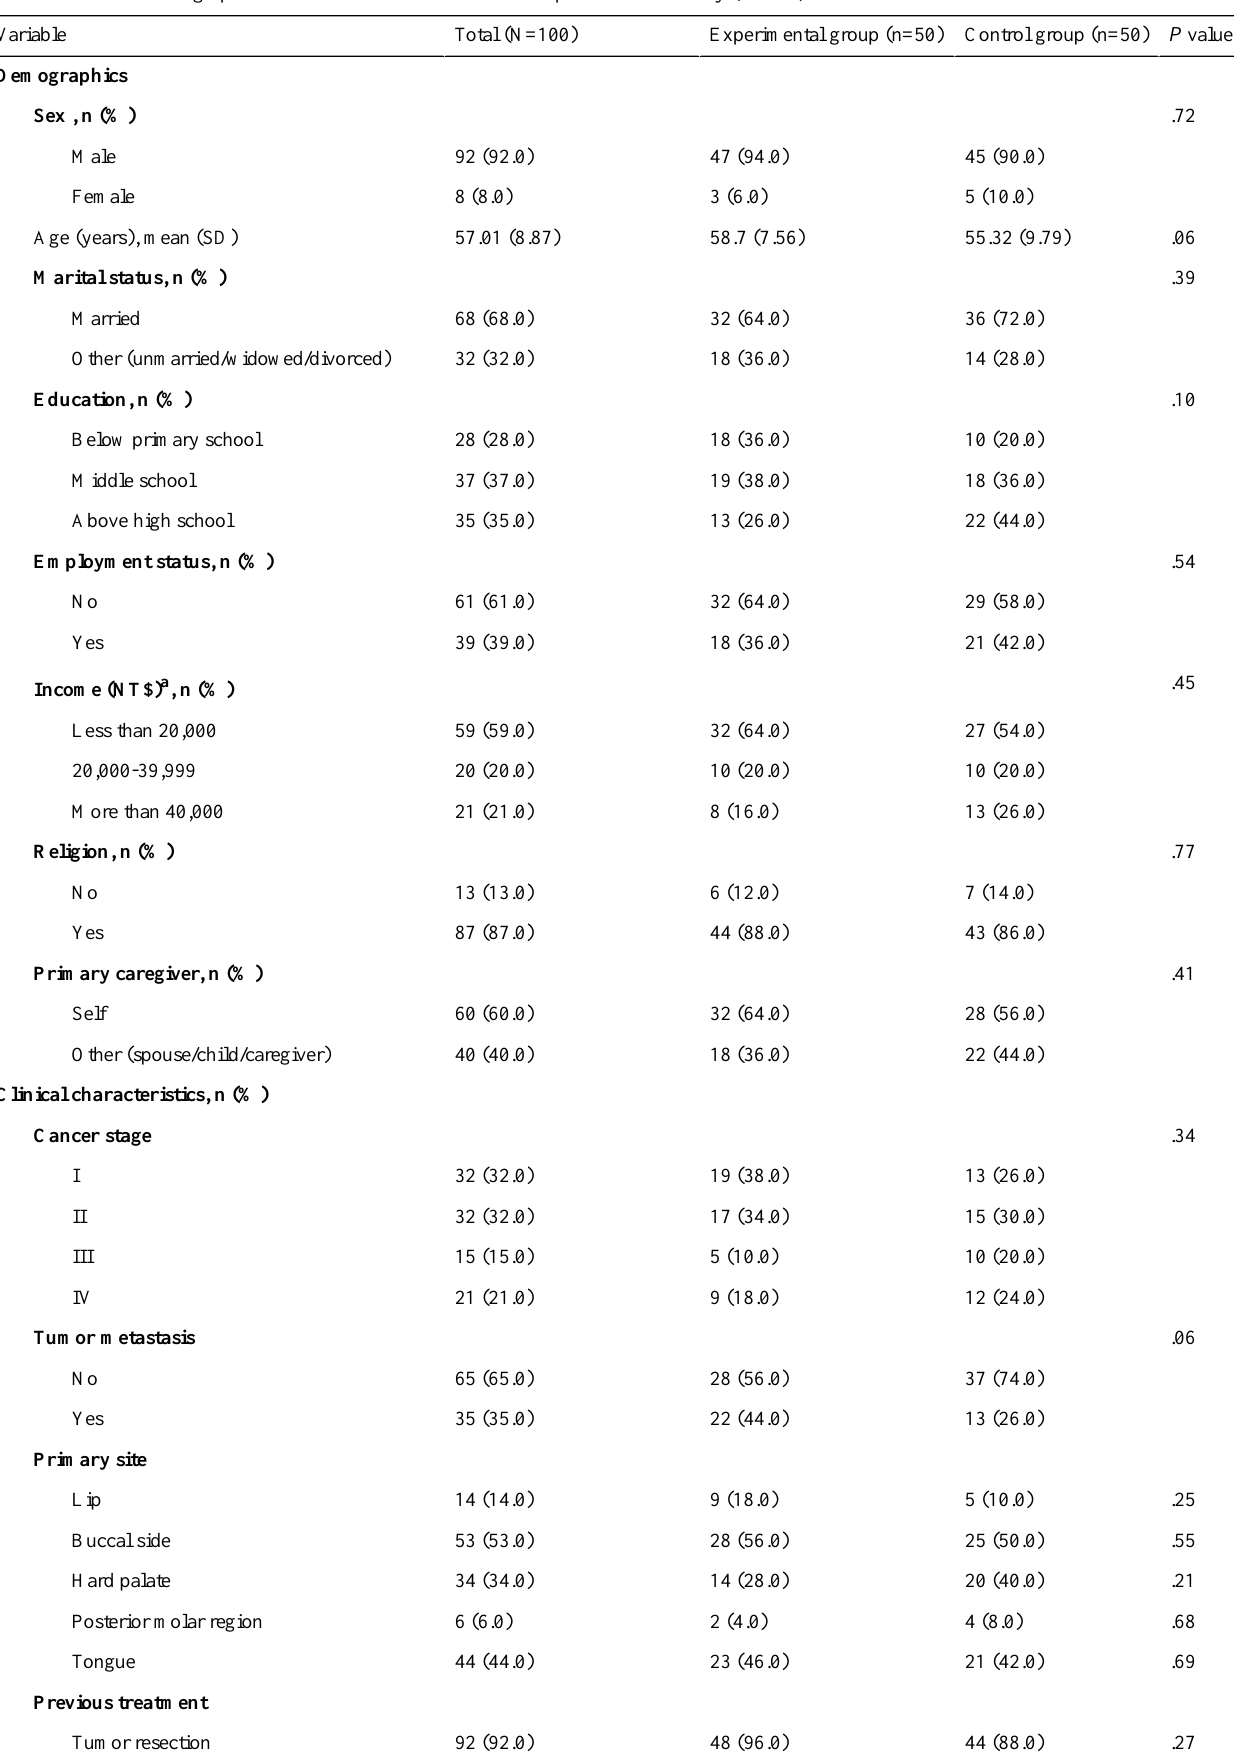
Table 1. Baseline demographics and clinical characteristics of the patients in the study